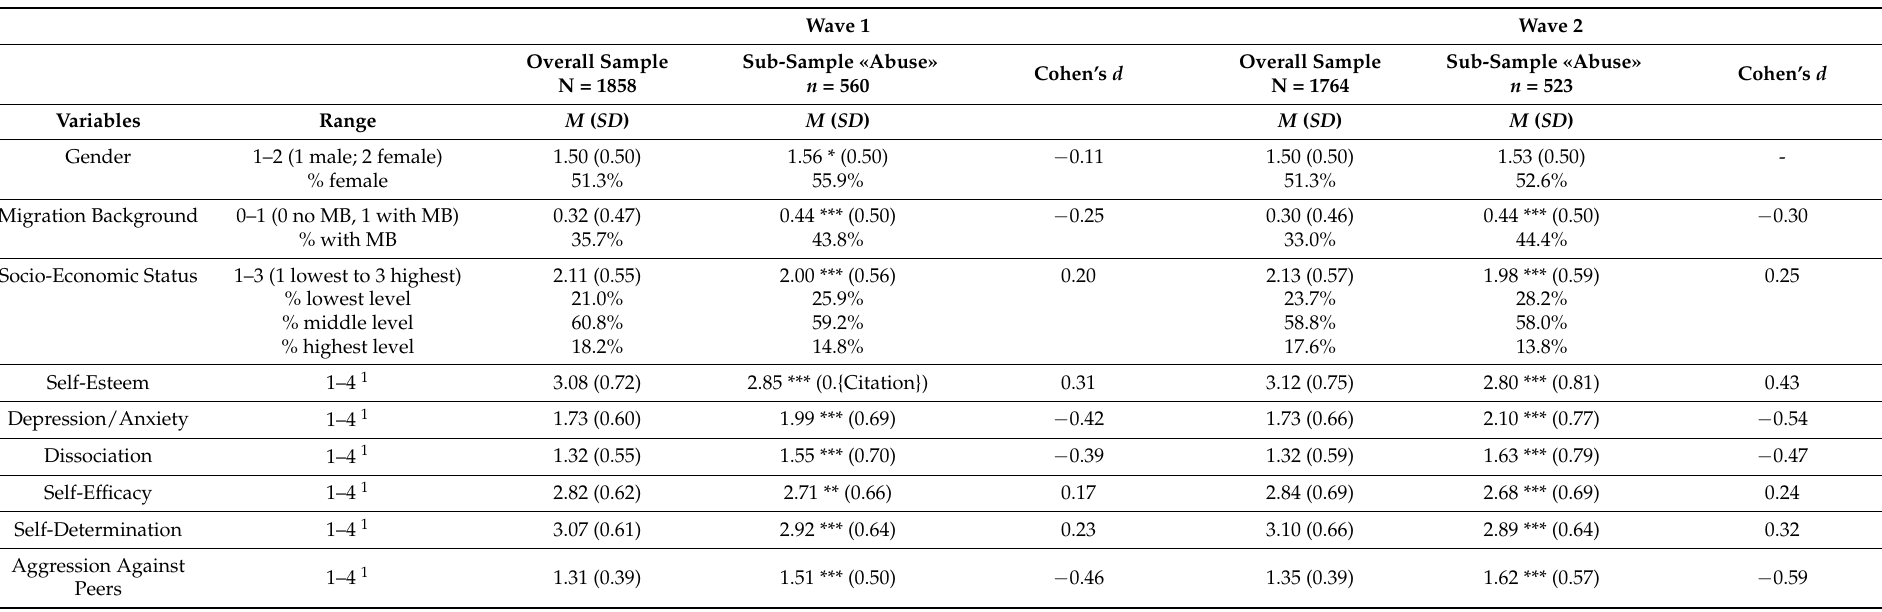
Table 1. Wave 1 and wave 2 sample mean levels (and standard deviations) of socio-demographic variables and all observed variables for the LCAs/LTA between the overall samples and the sub-samples of adolescences having experienced physical parental